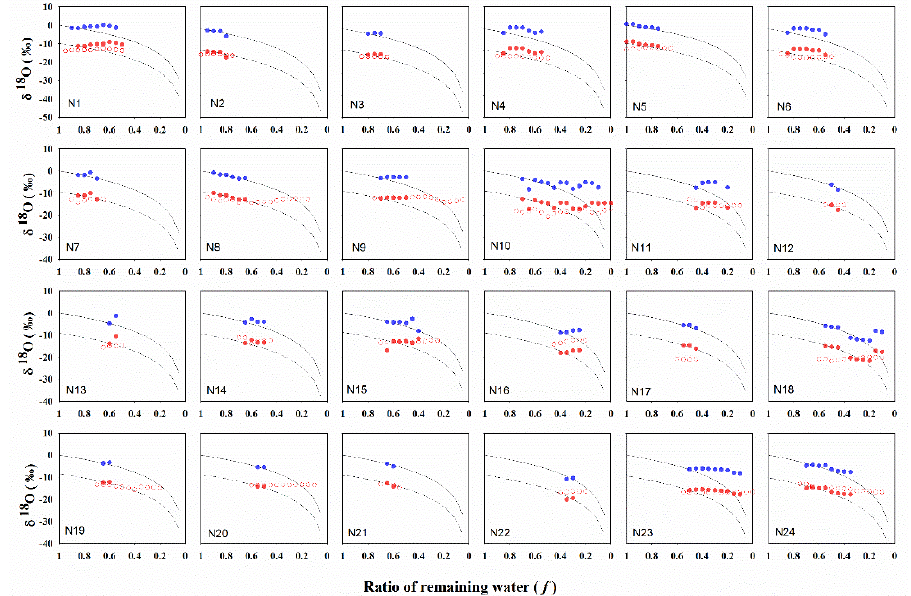
Figure 5. Changes of δ 18 O in precipitation and water vapor according to Rayleigh fractionation. Blue solid circles are the isotopic composition of precipitation ( δ p ), red solid circles are the isotopic composition of equilibrium water vapor isotopes ( δ e ) estimated by δ p and red hollow circles are the isotopic composition of water vapor ( δ v ). The initial values of hydrogen and oxygen isotopes were set to 0‰ (seawater) and the initial isotopic composition in vapor was derived from the evaporation of seawater. Solid and dashed lines represent Rayleigh simulations of the isotopic composition of precipitation and water vapor, respectively.